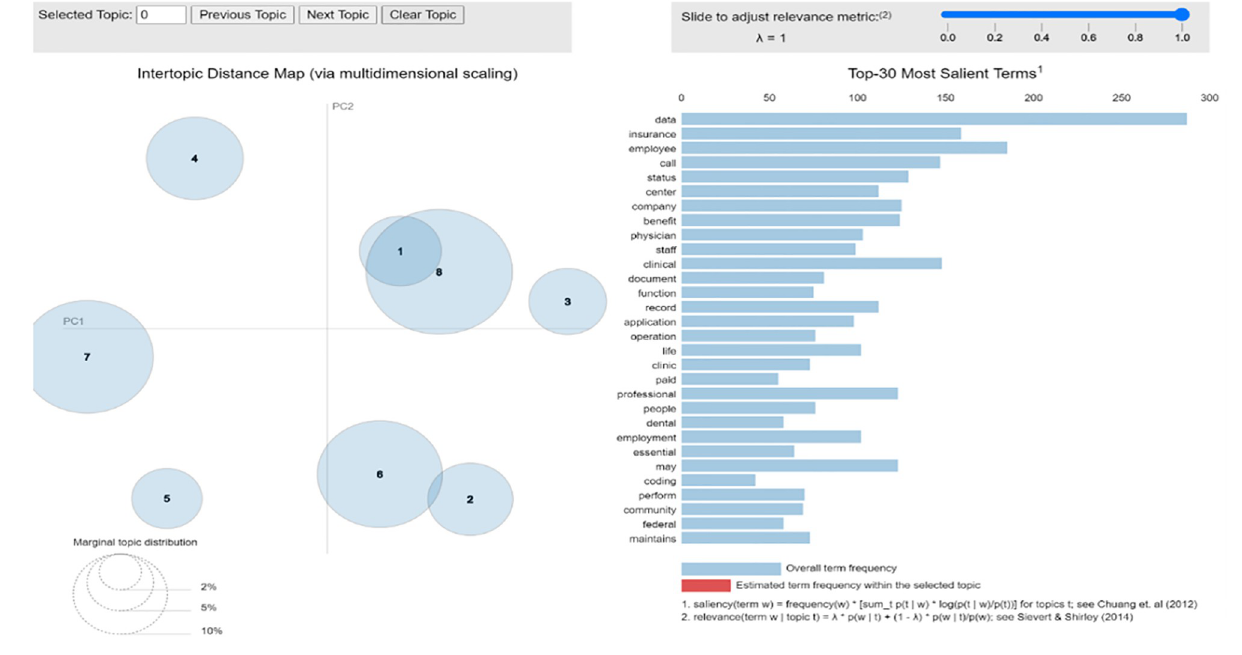
Fig 6. UK topic modeling results (Period 1).